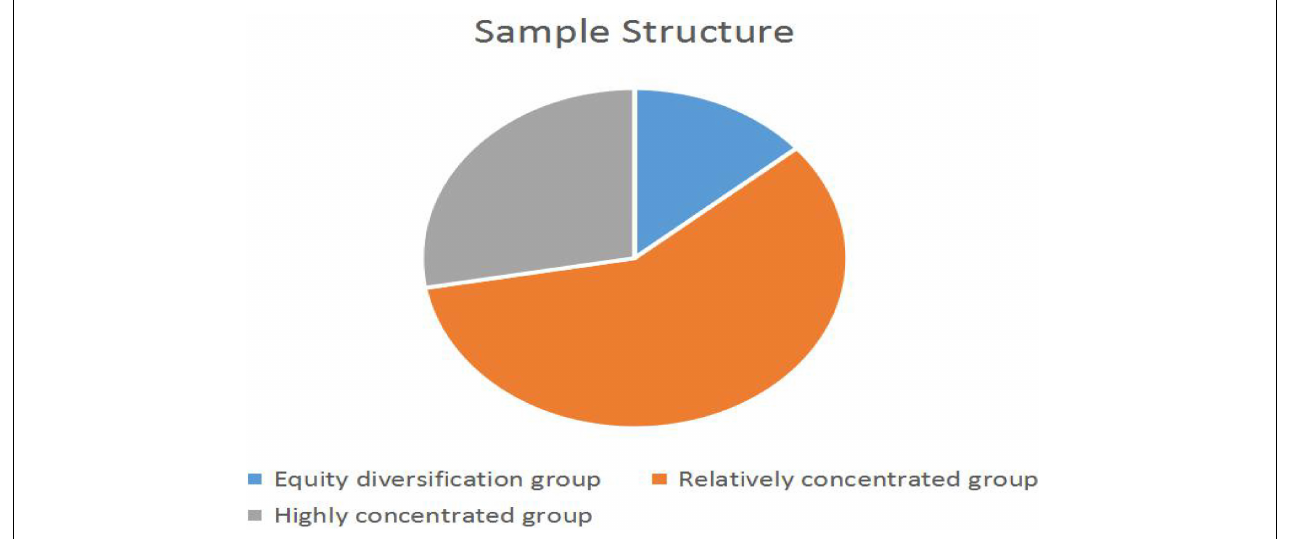
FIGURE 2 | The sample structure of real estate enterprises based on